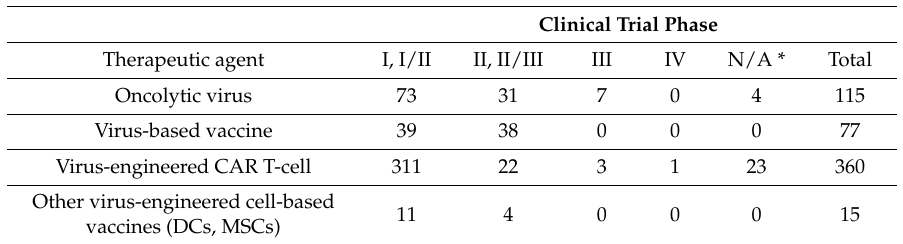
Table 1. A number or registered clinical trials of virus-based or virus-engineered therapeutic agents (according to